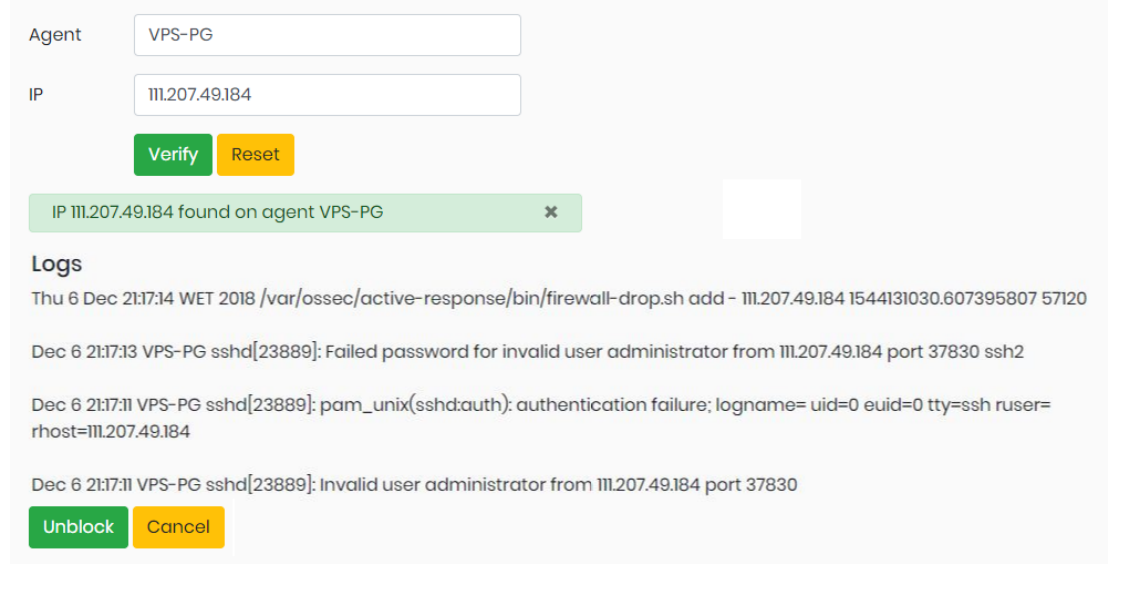
Figure 7. Layout of Active-response Manager UI to unblock